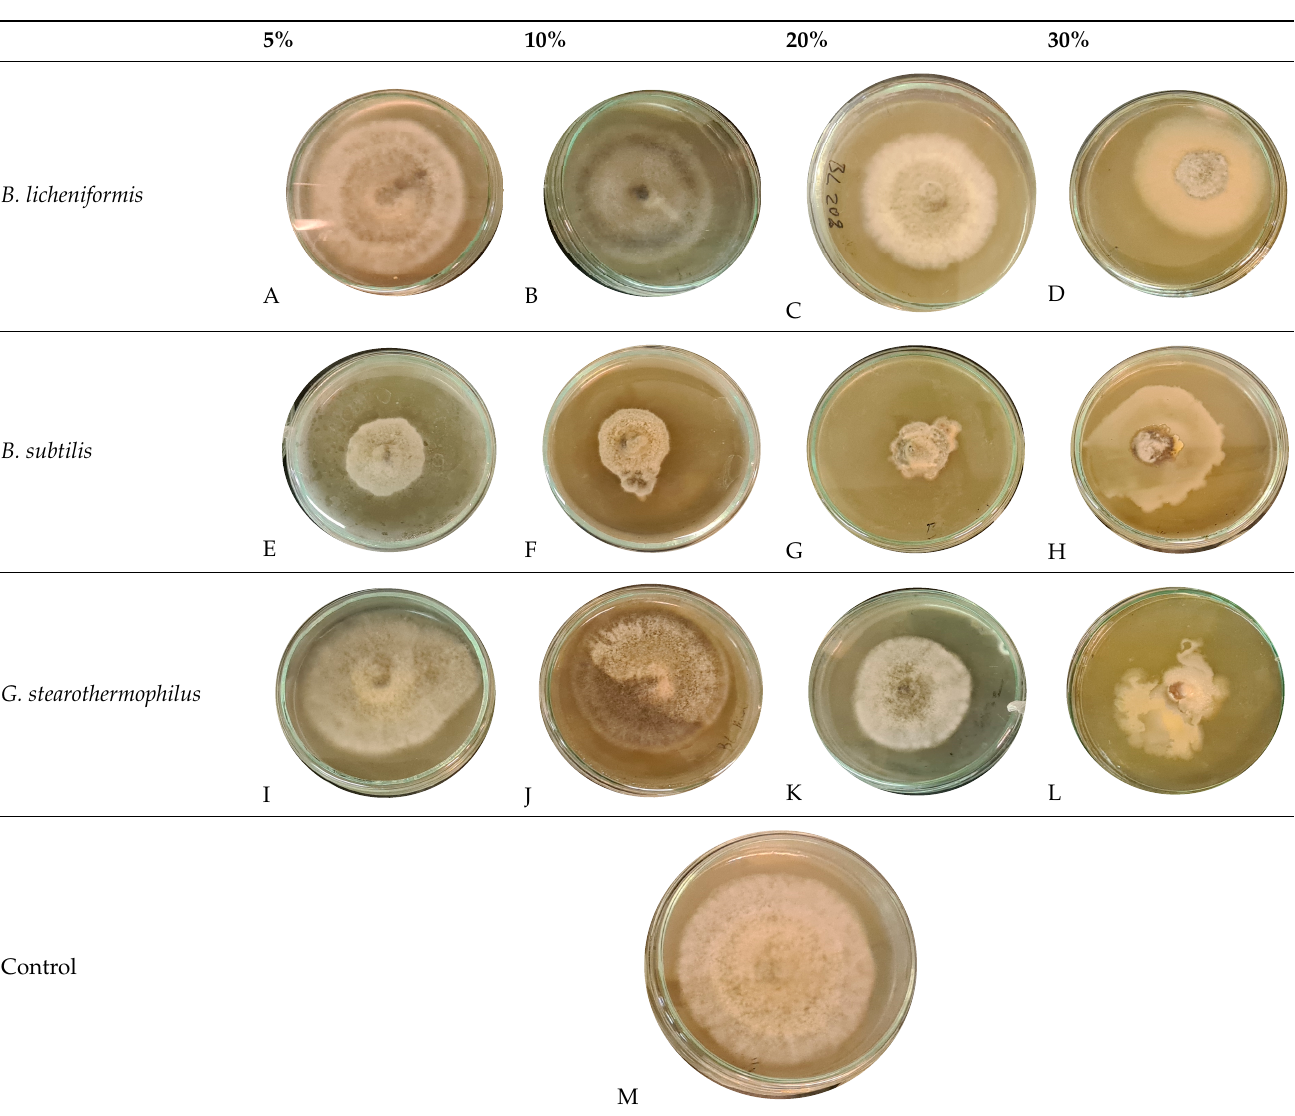
Table 3. Inhibition of A. alternata by B. licheniformis at 5% (A); 10% (B); 20% (C); and 30% (D); B. subtilis at 5% (E); 10% (F); 20% (G); and 30% (H); and G. stearothermophilus at 5% (I); 10% (J); 20% (K); and 30% (L); relative to the control (M).